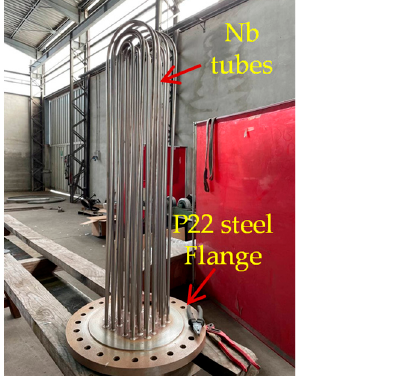
Figure 1. Main window of the Data Acquisition and Control System of the TRIEX-II facility during the heating up toward the test conditions. The main components are S100: storage tank; S200: hydrogen saturator; S300: PAV mock-up; EP100: permanent magnet pump; TFM: thermal fl ow meter.